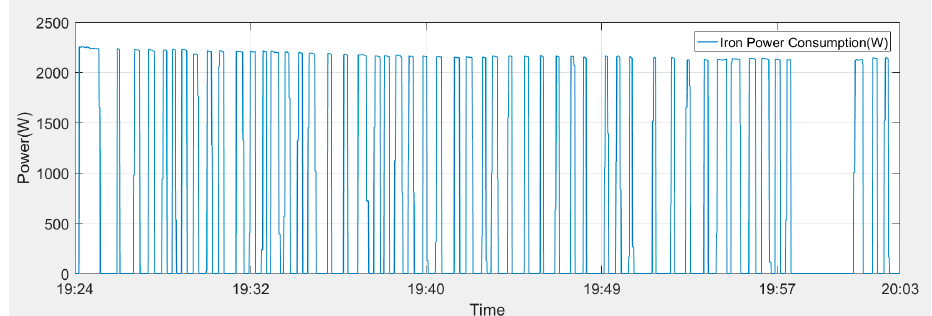
Figure 12. The power consumption curve for one ironing period in the operating mode level 2.